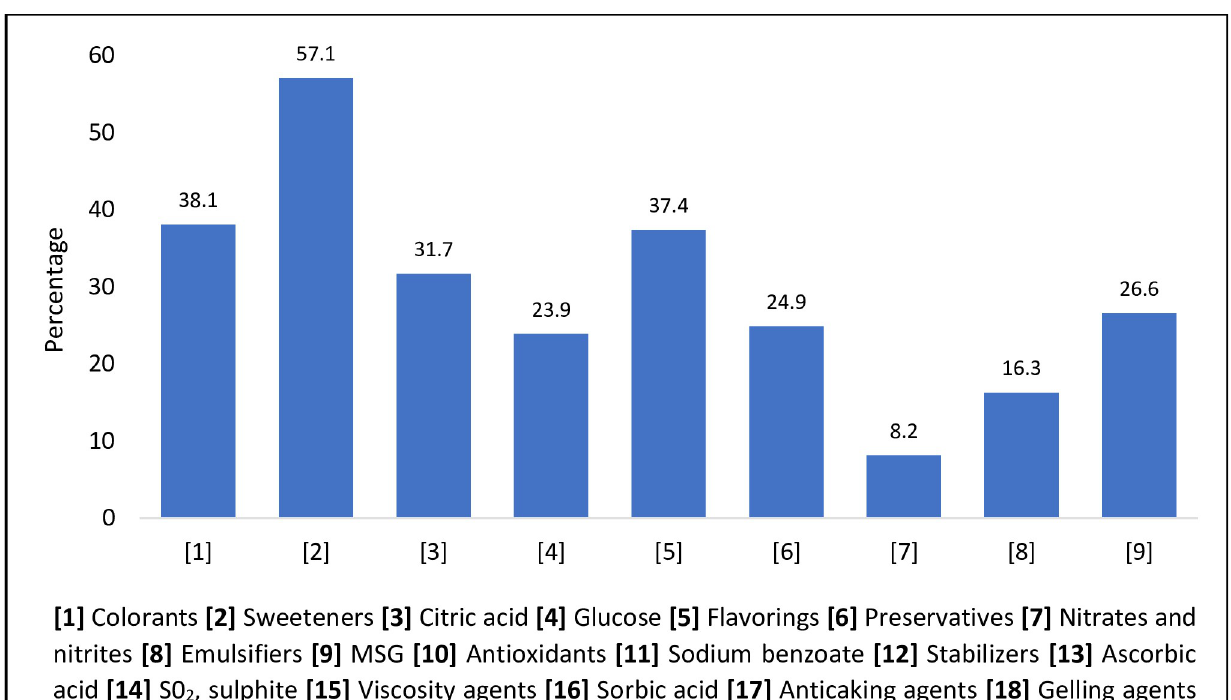
Fig 2. The percentage of respondents who recognize the different food additives (n =